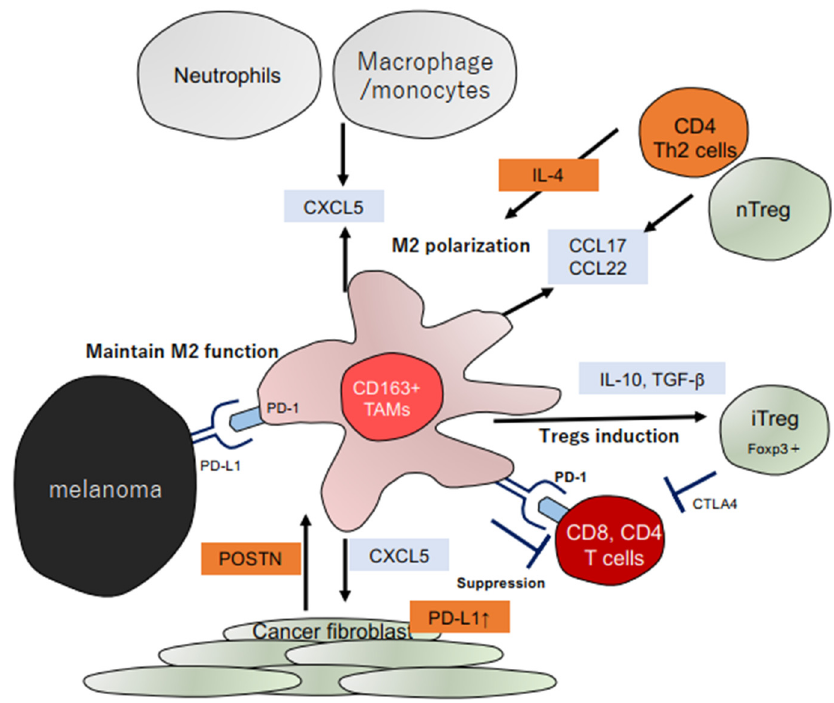
Figure 1. Schematic representation of TAMs in the melanoma tumor microenvironment. TAMs can be detected not only in cutaneous melanoma, but also in various non- melanoma skin cancers [11]. For example, CD163 + CD206 + TAMs that express immunosup- pressive functional molecules including arginase 1 and PD-L1 were also detected together with Tregs in EMPD [20,30,65]. TAMs produce CCL17 by the stimulation of RANKL de- rived from Paget cells to recruit Tregs in the tumor microenvironment, maintaining the immunosuppressive microenvironment in EMPD [78]. TAMs also produce proinflamma- tory cytokines CCL19 and CCL21 by the stimulation of LL37 to recruit CCR7+ Foxp3+ Tregs in lesional skin of EMPD [79,80] (Figure 2). Substantial numbers of M2-polarized TAMs were also detected in cSCC, and depletion of TAMs suppressed tumor growth